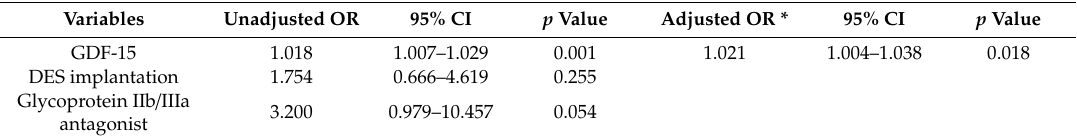
Table 3. Effects of variables on angiographic no-reflow in univariate and multivariate logistic regression analyses.